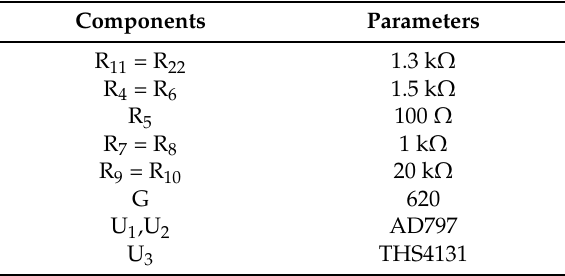
Table 2. Components of the pre-amplifier circuit. Components